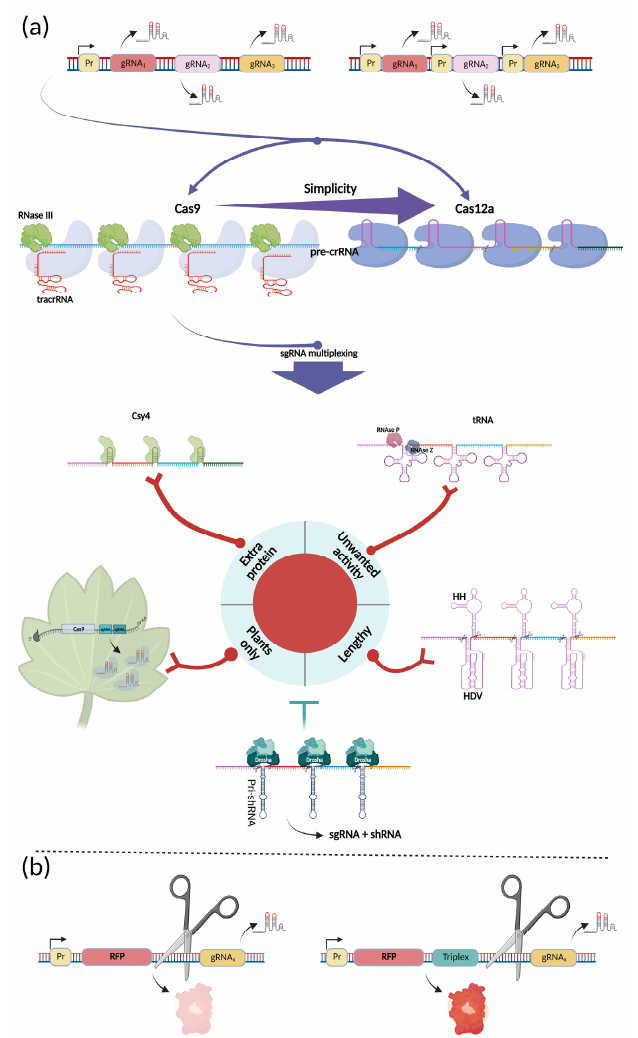
Figure 3. Multiplexing expression modules. ( a ) Different approaches of multiplexing have been developed for CRISPR-based applications. In general (top), the expression of multiple gRNAs can be provided by a single promoter or multiple promoters. In the first case, multiplexed gRNA arrays can be processed naturally by different mechanisms: for Cas9, pre-crRNA is processed by the Cas9/RNase III/tracrRNA complex, while for the Cas12a-based systems, processing of pre-crRNA is simpler and is mediated by the single effector. As for Cas9, a deployment of alternative multiplexing strategies is important when sgRNAs are used. These strategies include Csy4-mediated cleavage, tRNA-mediated RNaze P/Z processing, ribozyme-mediated cleavage, native sgRNA processing in plants, and shRNA-based strategy. Red neuron-like connections depict the limitation of each Cas9-multiplexing approach, when applicable; ( b ) A triple helix RNA (named triplex) protects RNA from degradation, stabilizing its 3 (cid:48) end, thus allowing further effective translation. Figure was created using